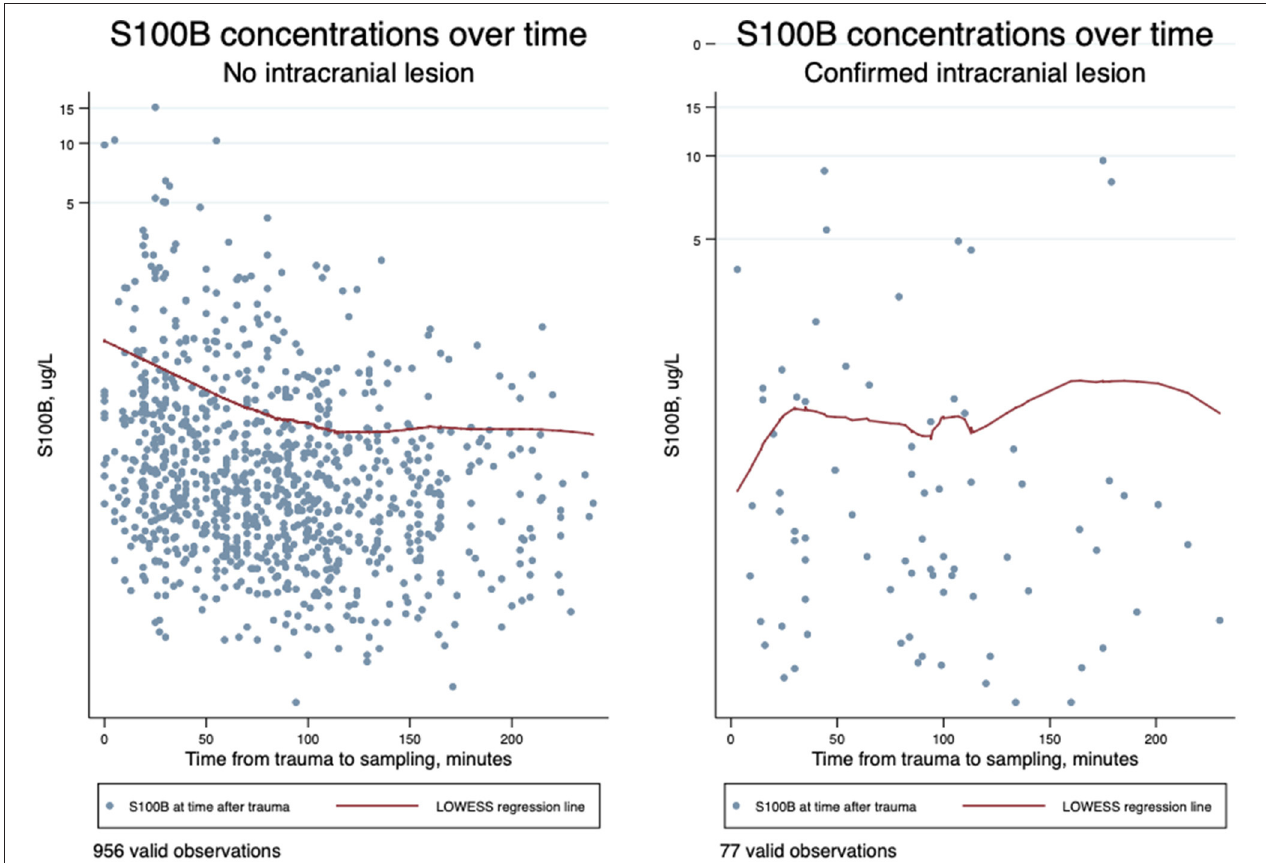
FIGURE 5 | Scatterplot of time from trauma to blood sampling in minutes (the first 4h) on an ordinary scale and serum S100B concentrations in µ g/l on a logarithmic scale overlaid with the locally weighted scatterplot smoothing (LOWESS) regression line demonstrating temporal changes of S100B values in samples from patients without intracranial lesions (N = 956) and in samples from patients with a confirmed intracranial lesion ( N =